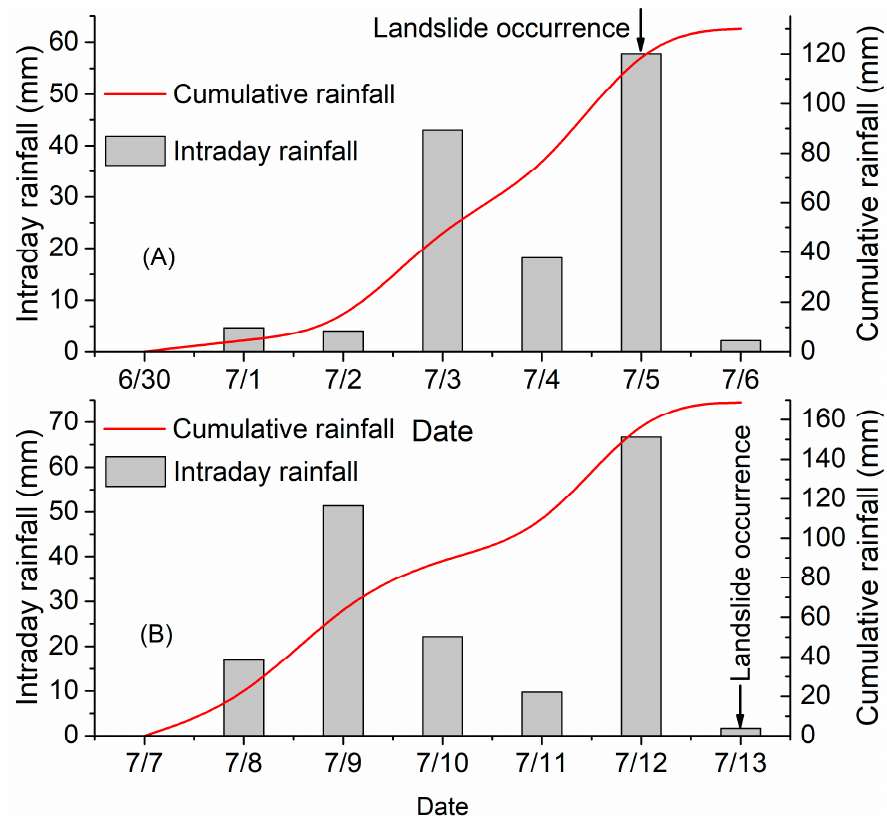
Figure 9. ( A , B ) Intraday and cumulative rainfall from 30 June to 6 July 2011 in Lueyang County and from 7 July to 13 July 2013 in Wuqi County.